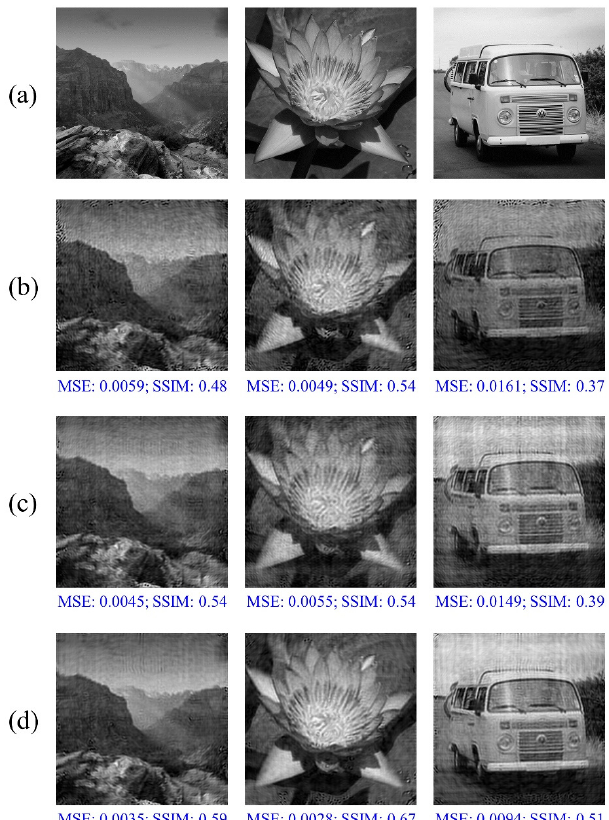
Figure 7. Reconstructed images of three different target images. ( a ) The target images. (obtained from Pixabay) ( b ) The reconstructed images of DBS BCGHs. ( c ) The reconstructed images of SA BCGHs. ( d ) The reconstructed images of SABS BCGHs. Table 1. Performances of different BCGH methods.